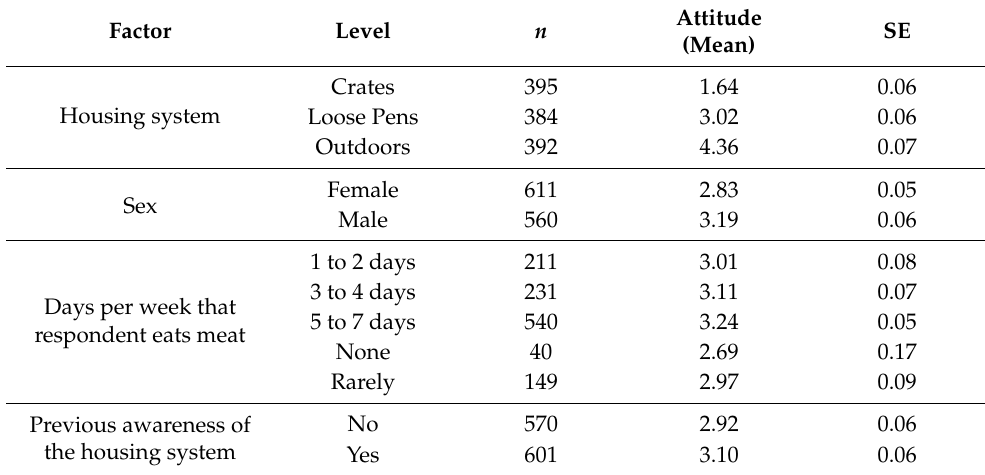
Table 2. Factors associated with attitudes towards the farrowing housing systems among participants ( n = 1171). Attitude score is a construct consisting of the average of three 5-point Likert scales, with higher numbers indicating a more positive